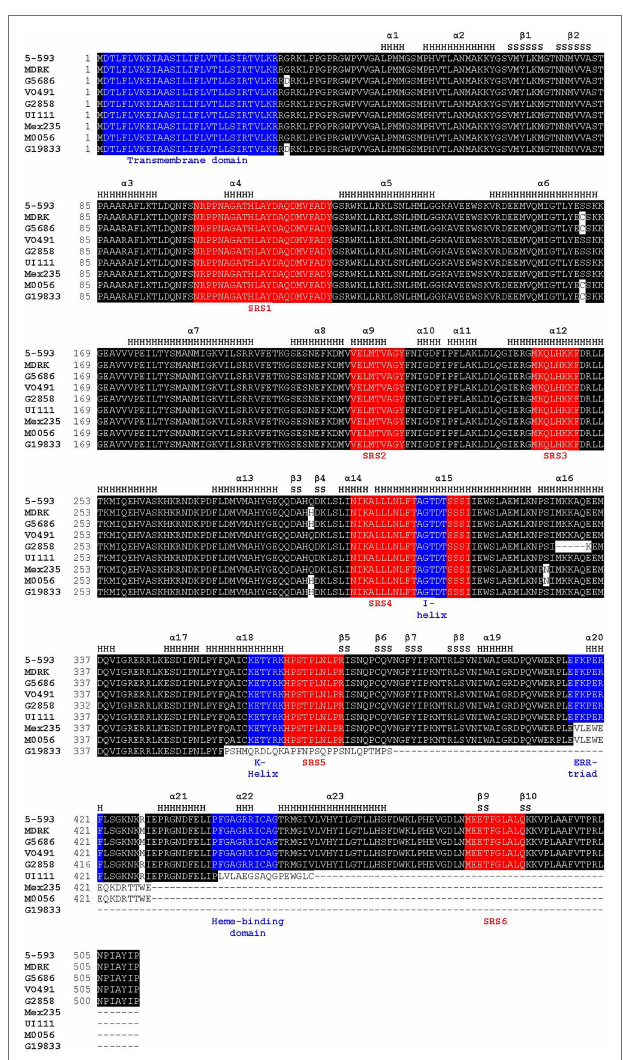
FIGURE 3 | Amino acid alignment of proteins of representative genotypes for the nine Phaseolus vulgaris flavonoid 3 ′ 5 ′ hydroxylase haplotypes. Positions of α -helices (H) and β -sheets (S), as defined by MODELER, are noted above the alignment. The sequence substrate recognition sites highlighted in red, and CYP450 motifs shared among CYP450 proteins, highlighted in blue, are noted below the alignment. The following P450 regions were identified based on previous domain and matrix structure of the plant CYP75 family of proteins: SRS1, SRS2, SRS3, SRS4, I-helix (a subcomponent of SRS4), K-helix, SRS5, ERR-triad, heme-binding domain, and SRS6 (Falginella et al.,